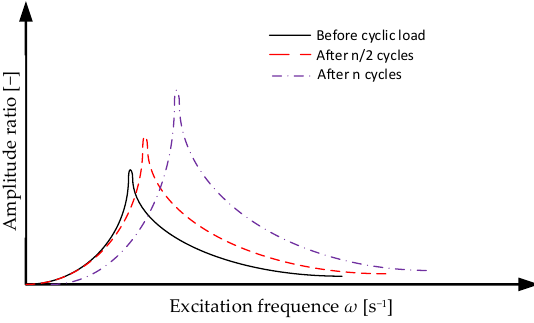
Figure 2. Plots of the dependence of the ratio of amplitudes 𝑥 𝑎 / 𝑥 0 on the excitation frequency 𝜔 for successive, cyclic loads.